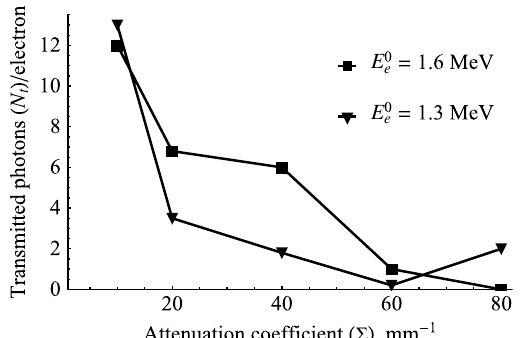
Fig. 1. Intensity of transmitted photons versus the attenuation parameter, for E 0 e ¼ 1 : 6 MeV and E 0 e ¼ 1 : 3 MeV ( a ¼ 0 : 99, g ¼ 0 : 98, D ¼ 5 : 0 mm).